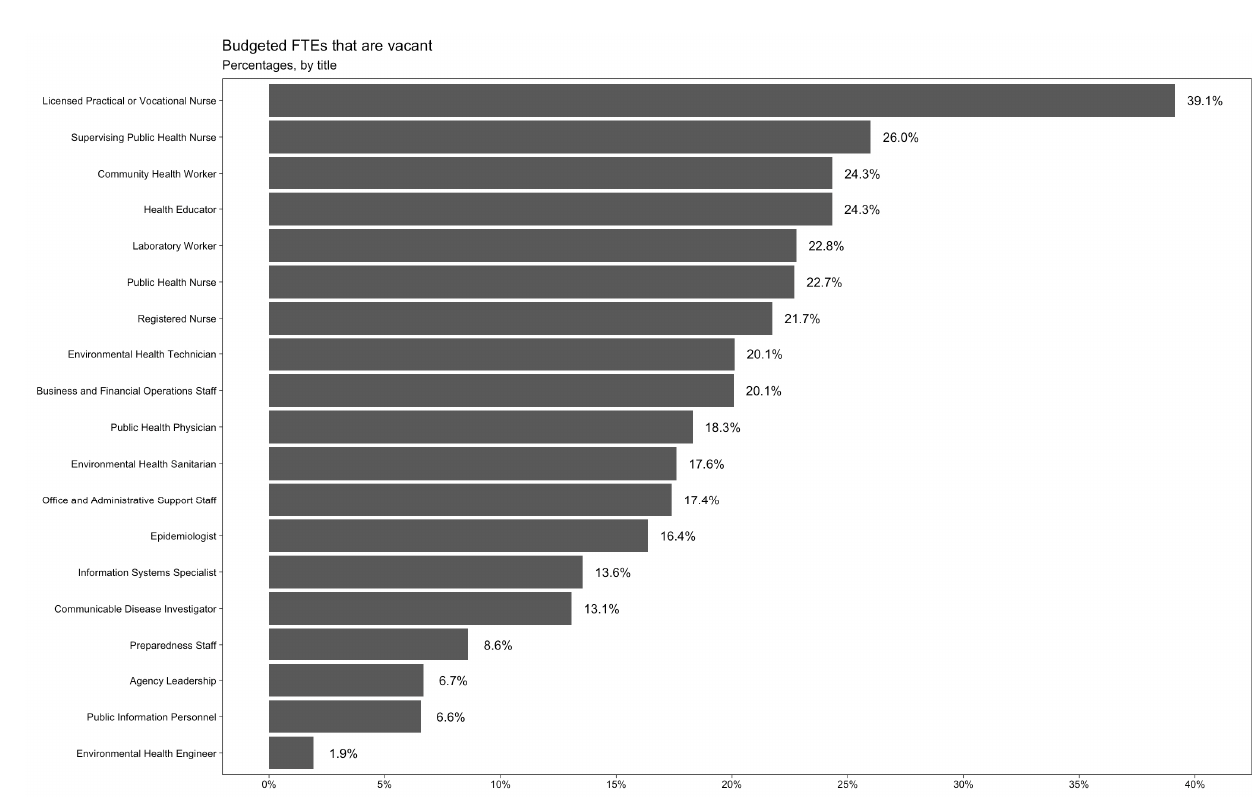
7 of 15 Table 5. Vacancy Rates Among LHDs in NYS (2019 vs. 2021). Budgeted